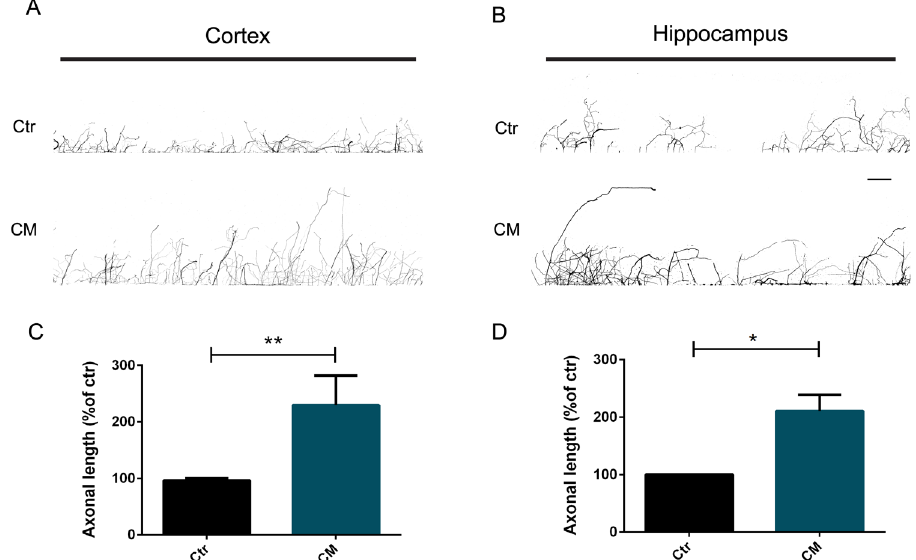
Figure 3. Axonal-specific stimulation with CM induces axonal growth of CNS neurons. ( A , B ) Effect of local application of CM on axonal outgrowth. Cortical ( A ) and hippocampal ( B ) axons present in the axonal compartment were stimulated with CM for 24 h at DIV5-6. Axonal outgrowth was evaluated by immunocytochemistry using anti-tubulin β III. The area selected comprises 3 mm of chamber length which comprises the area between the first and the last microgrooves. Contiguous images were taken using an AxioObserver Z1 fluorescent microscope with a PlanApochromat 20 × objective and assembled into a single image using the ZEN 2011 software. ( C , D ) Quantification of axonal length. Results show that in the presence of CM the axonal network significantly increases comparatively to control, demonstrating that specific local application of CM to cortical and hippocampal axons promotes axonal outgrowth. Axonal network was measured using Neurolucida software. Bars represent the mean ± SEM of 3 independent experiments. * Represents p = 0.0286 by Mann Whitney unpaired t-test when compared to Ctr. ( C ) ** Represents p = 0.0079 by Mann Whitney unpaired t-test when compared to Ctr. The scale bar is 250 µ m.